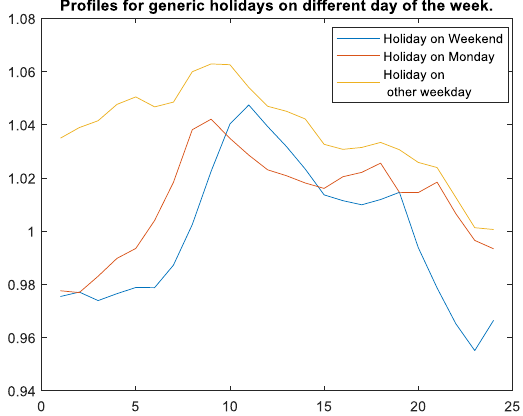
Figure 12. The different profiles that a generic holiday may have depend on the day of the week. The difference between them can be explained by considering the next and previous